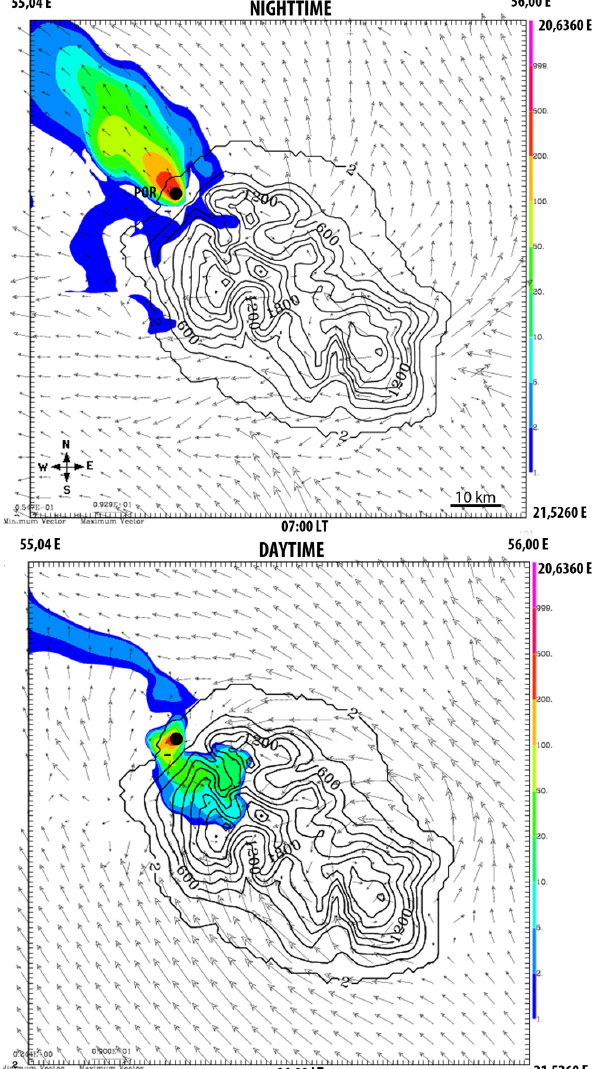
Fig. 13. ALIZ5 – horizontal field of the tracer dilution ratio (per mil of the concentration at emission point) at the first model level above the ground, emitted from BRG, at 11:00 (top) and 15:00LT